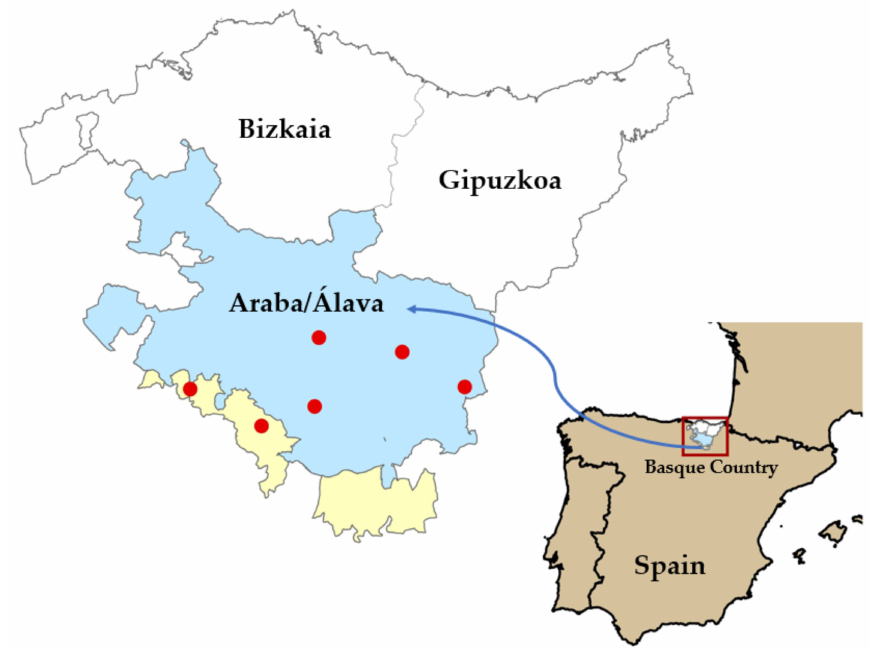
Figure 1. Study area. Dry (D) regions are shown in yellow and Wet (W) regions in blue. Red dots indicate those municipalities where the 17 studied plots are located. These plots exemplify the most representative barley cultivation practices in the province of Araba/ Á lava. Details about the plots are shown in Table A1 (Appendix